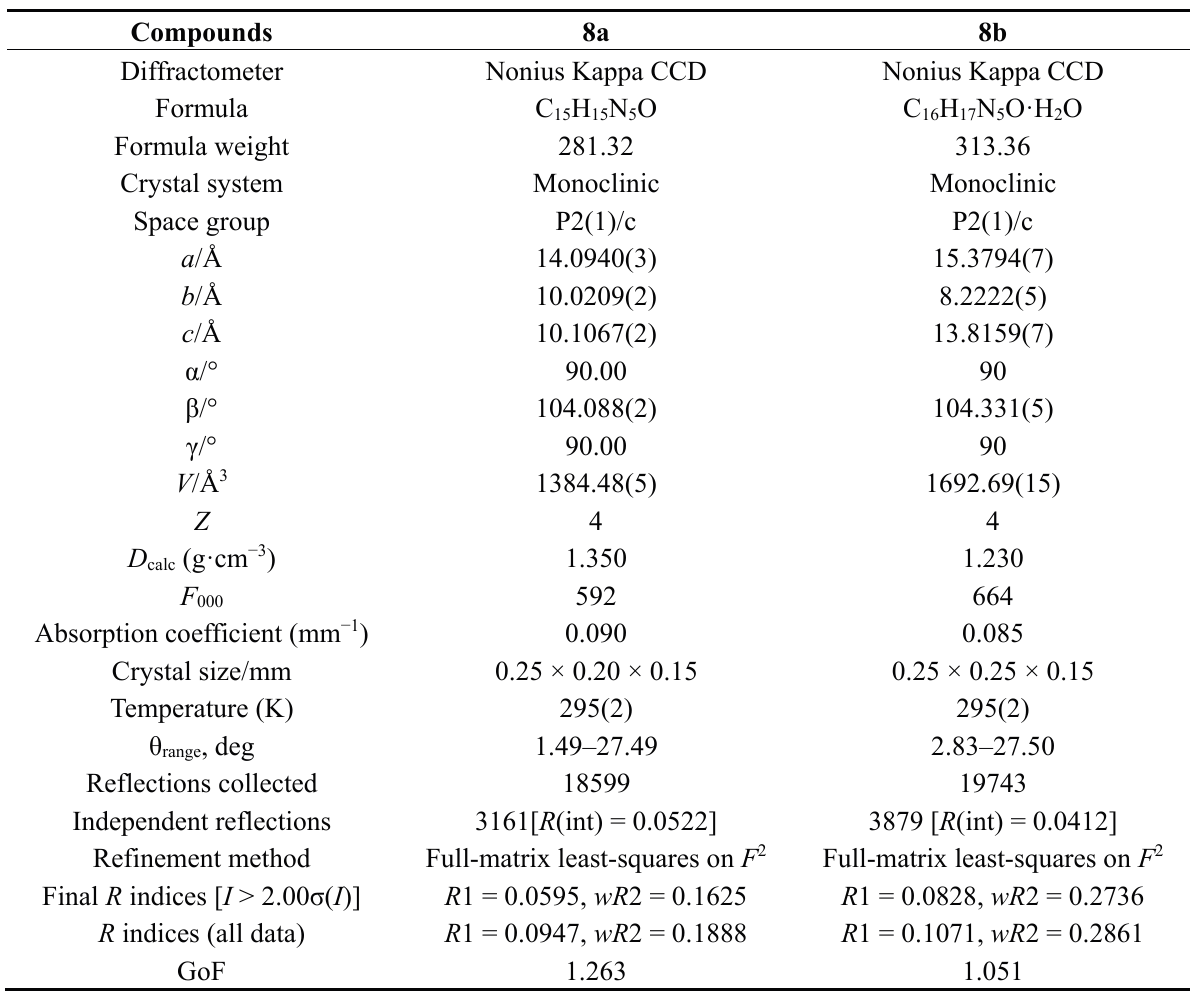
Table 1. Crystal data of semicarbazides 8a and 8b